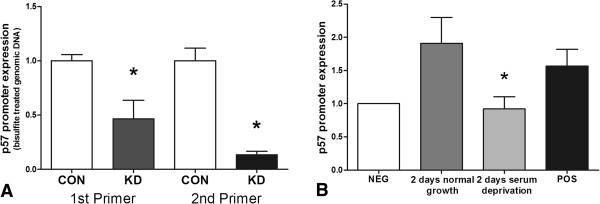
p57Kip2 promoter methylation and NAP1L1 binding. Genomic DNA of normal BON cells and NAP1L1 silenced BON cells were treated with bisulfate, which converted cytosine of unmethylated p57Kip2 promoter into uracil. Methylation-specific polymerase chain reaction (MSPCR) was performed using two p57Kip2 promoter primers (forward first primer, CGCCAATCGCCGTGGTGTTG; forward second primer, ACTACATTATGCTAATCGCG; reverse primer, GCCAGGCCTGAGCGAGCGAG). Unmethylated p57Kip2 promoter resulted in low PCR products as demonstrated for NAP1L1-silenced cells (A) (*p < 0.05) indicating that NAP1L1 controls p57Kip2 expression by methylation of its promoter. In chromatin immunoprecipitation (ChIP) experiments, using the Pierce Agarose ChIP Kit (Thermo Scientific) according to the manufacturer’s instructions, a direct binding of NAP1L1 protein to the p57Kip2 promoter was evident in normal growing BON cells; non-proliferating cells did not silence the p57Kip2 promoter (B) (*p < 0.05). The calculated promoter expression in NAP1L1-bound DNA fragments is shown in relation to the control. Mean ± SEM.